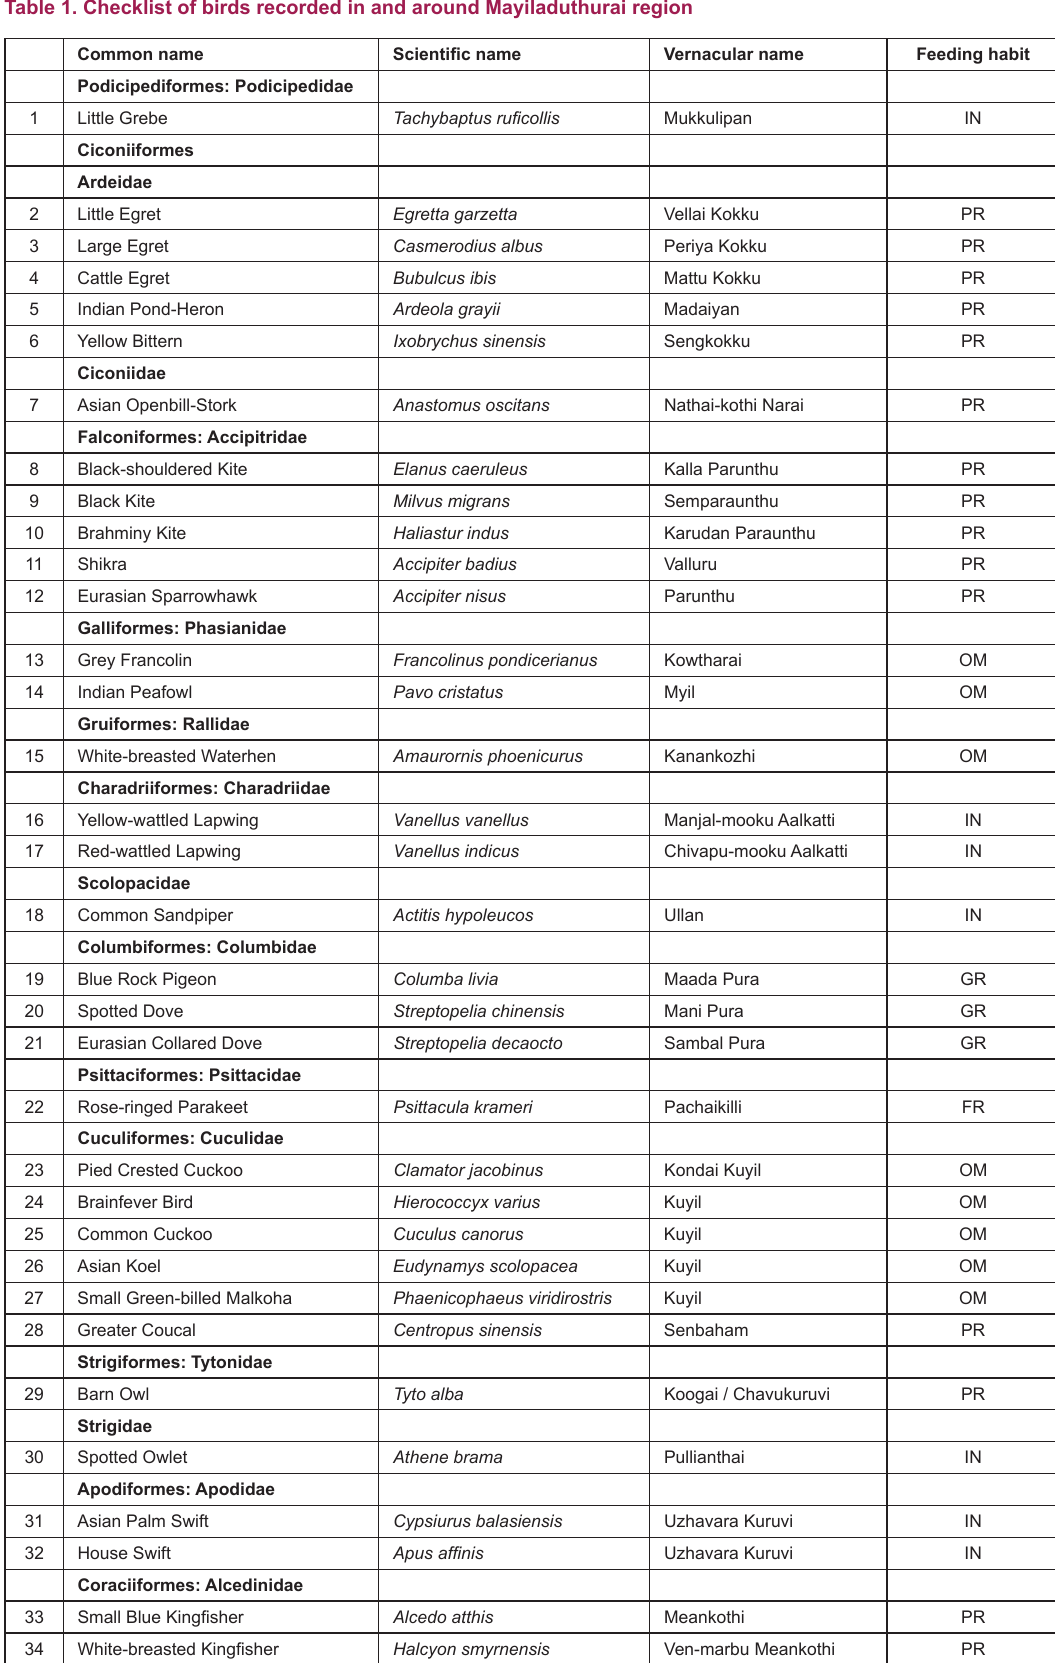
Table 1. Checklist of birds recorded in and around Mayiladuthurai